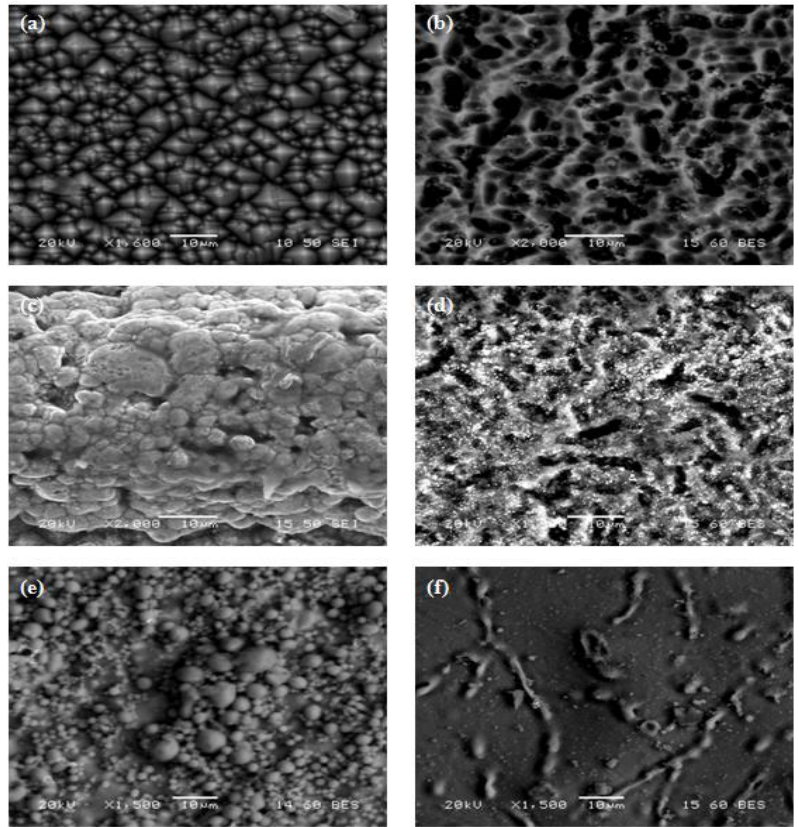
Figure 3. Scanning Electron Microscopy (SEM) images of recovered polycrystalline Si flakes before cleaning ( a , c — front, e — back) and after cleaning ( b , d — front, f — back).